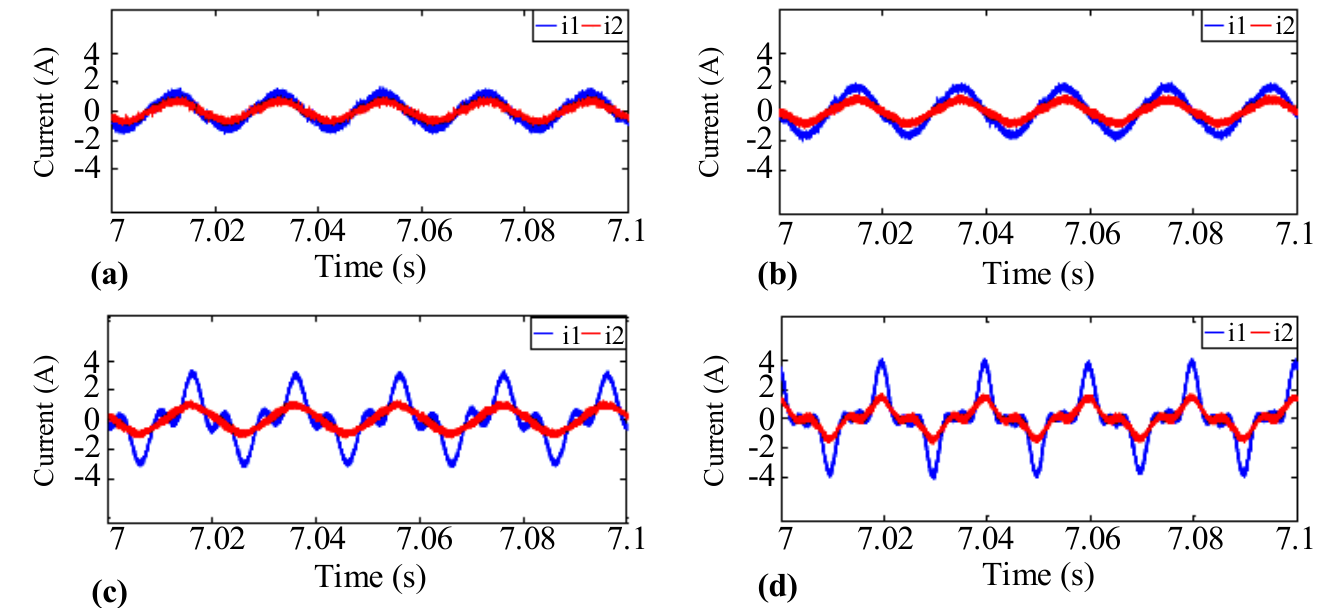
Figure 17. Output current changes in the first scenario using ( a ) the first strategy, ( b ) the second strategy, ( c ) the third strategy, and ( d ) the fourth strategy.